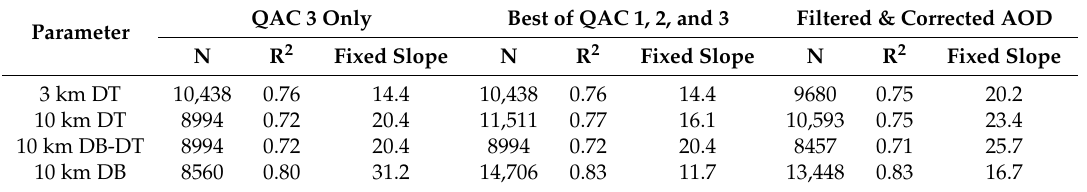
Table 3. Performance statistics for each AOD parameter in the Atlanta case